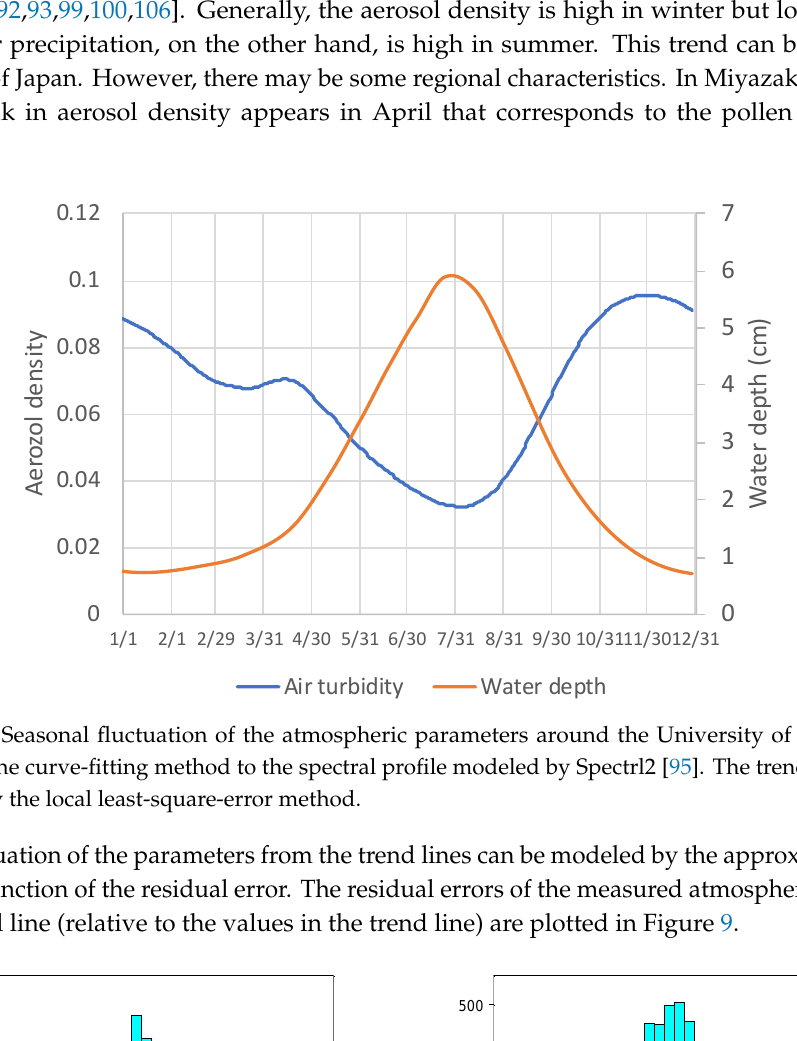
from the trend line (relative to the values in the trend line) are plotted in Figure 9.